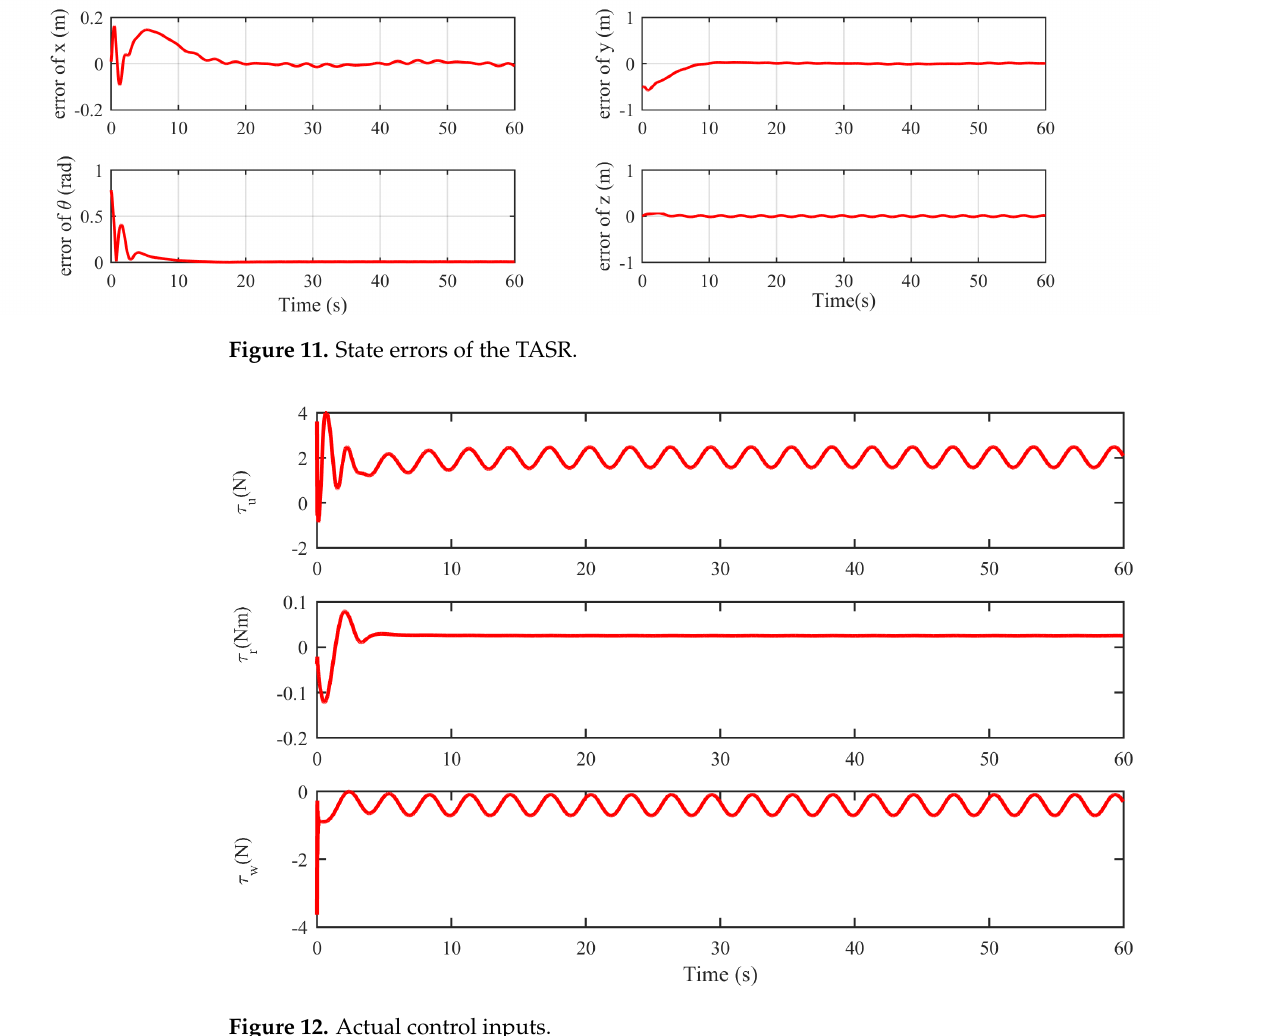
Figure 12. Actual control inputs.